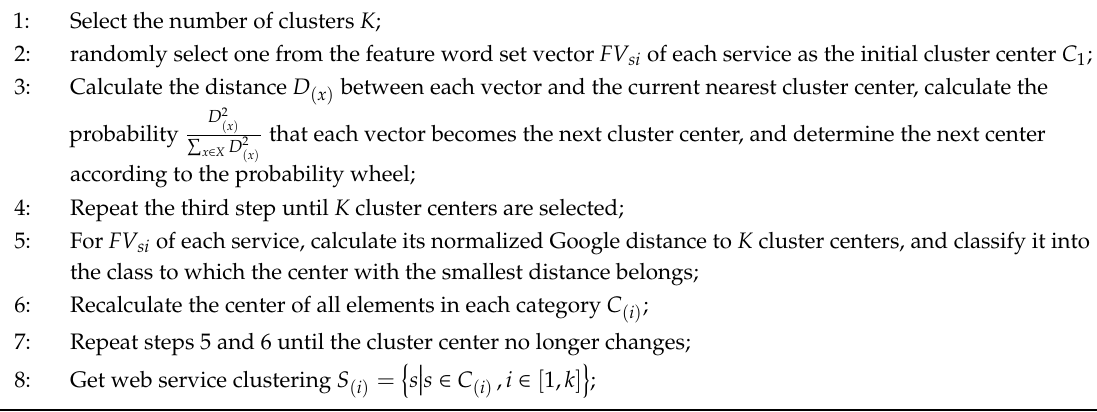
Algorithm 1 K-means ++ clustering based on service function feature word set